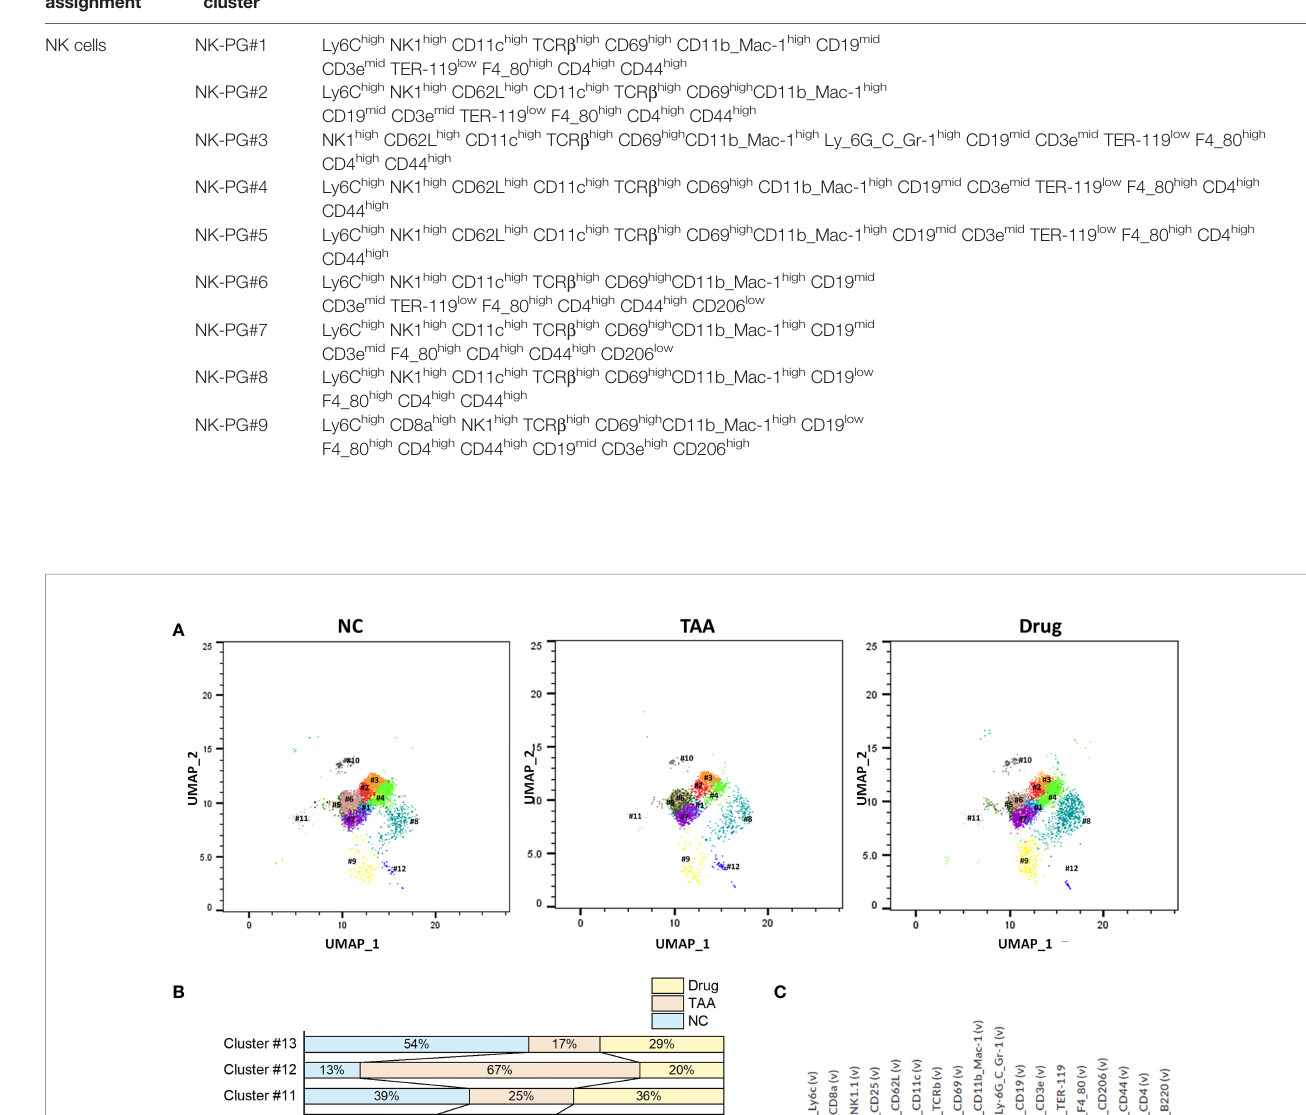
TABLE 5 | Comparison of NK cell PhenoGraph clusters with manually gated population and associated marker expression. Cell assignment